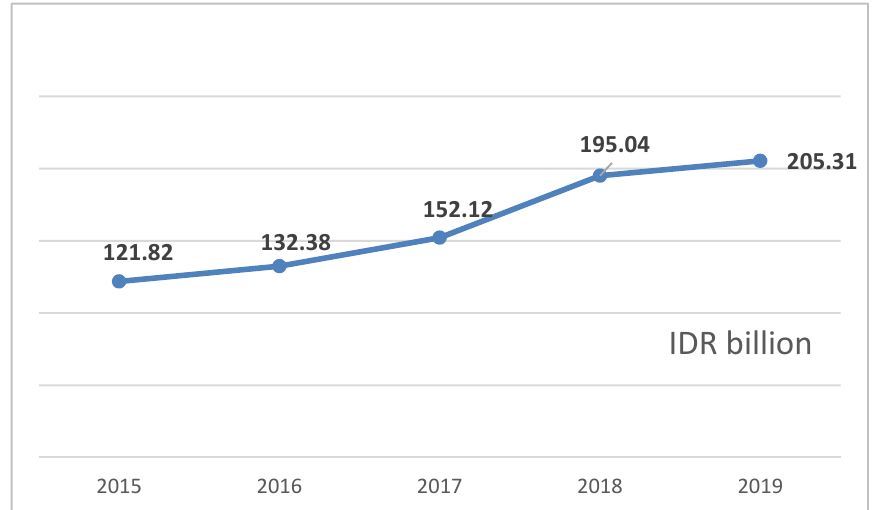
Figure 5. Total non-tax state revenue from the ecological tourism sector in 2015–2019.